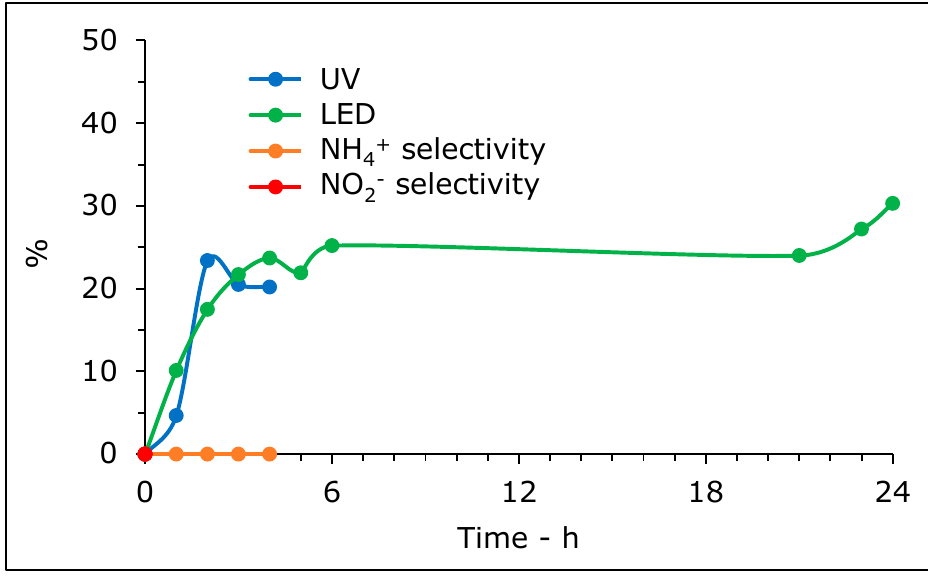
Figure 8. Photo-reduction of NO 3 − under UV lamp (Irr. 260 W/m 2 ) or LED with 0.1% Ag/FSP as photocatalyst (substrate/cat ratio 34 mmol NO3 − /g cat ), NaNO 3 (1 mM), pH 5, rt, 250 mL (UV, Reactor 1) or 1000 mL (LED, Reactor 2) of solution.